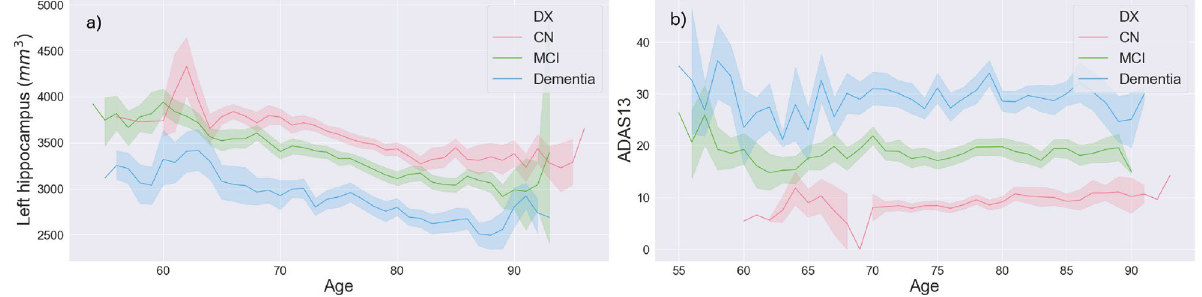
Figure 1. Mean values for ( a ) the volume of the left hippocampus, and ( b ) the ADAS13 score over age, based on the cross-sectional ADNI